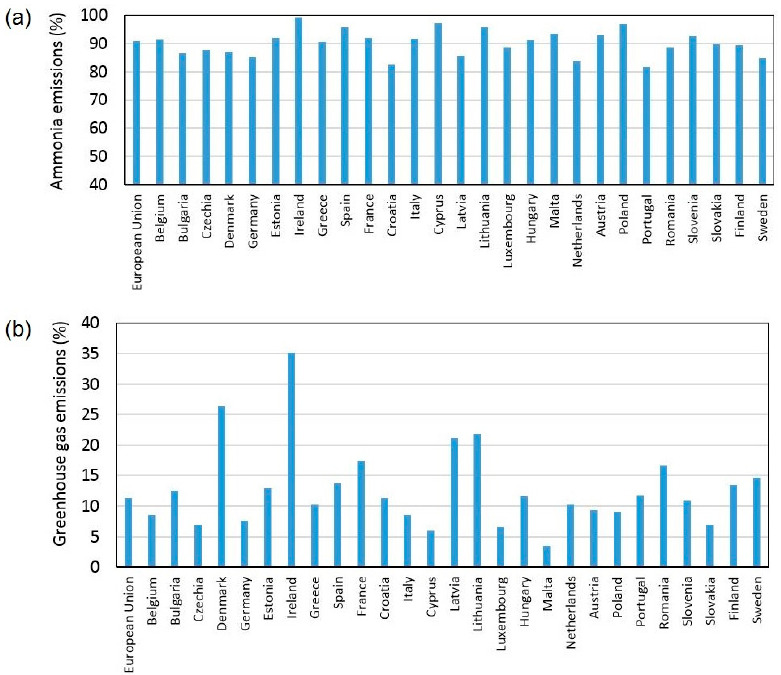
Figure 11. Anthropopressure of agriculture in Poland and the EU in 2020, data from Eurostat [70]: ( a ) ammonia emissions from agriculture as % of the total emission, ( b ) greenhouse gas emissions from agriculture as % of the total emission.